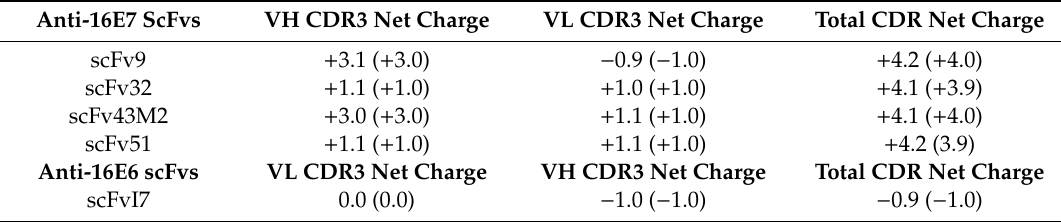
Table 2. Analysis of the ScFv CDRs Net Charge.